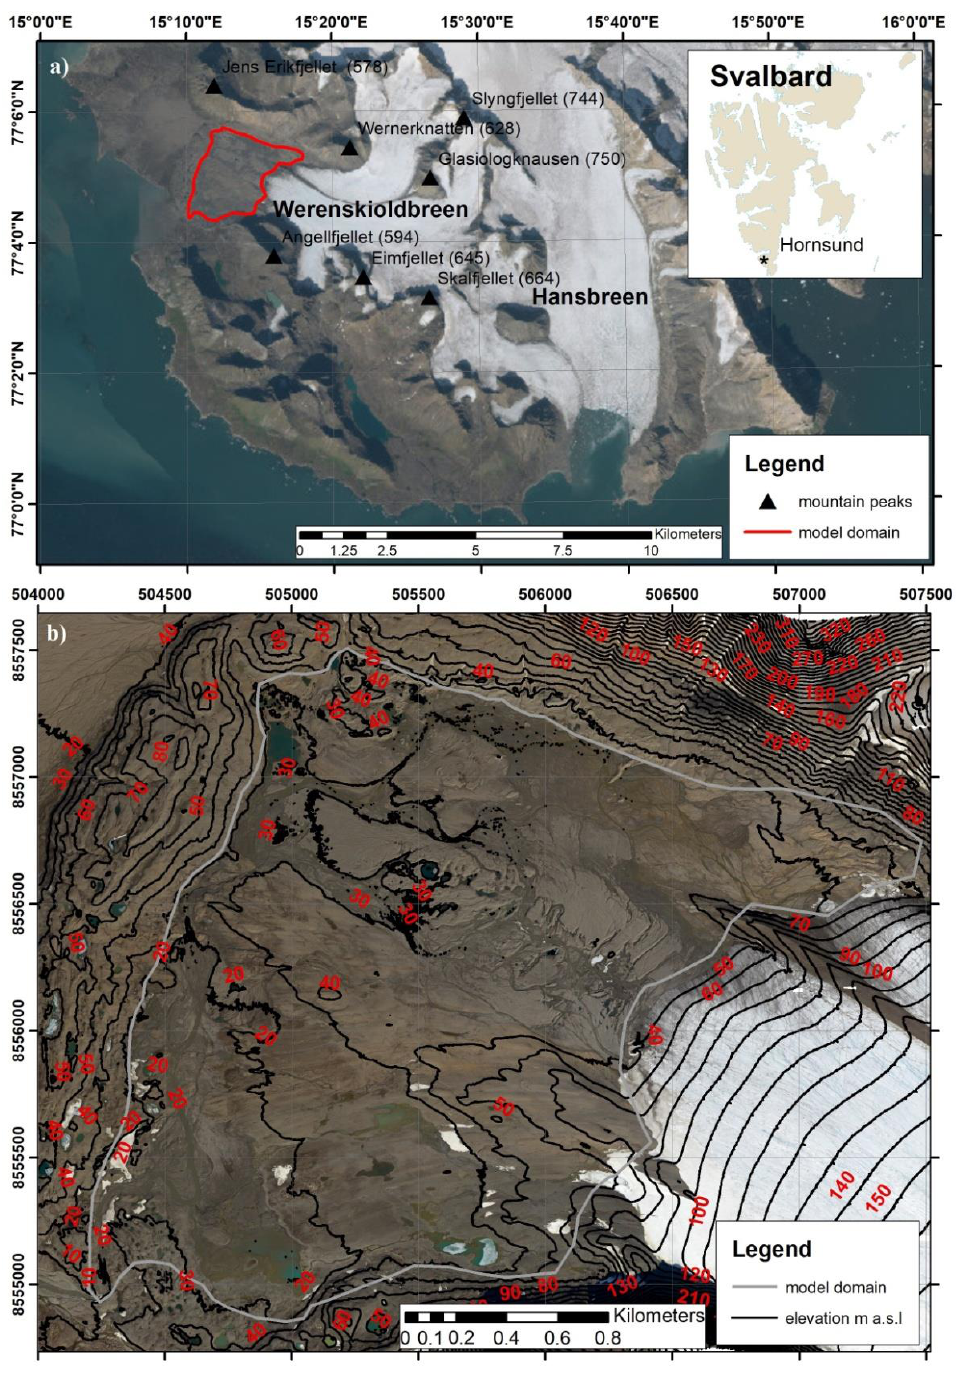
Figure 1. The study area of the Werenskioldbreen basin: ( a ) Hornsund Fjord, south Spitsbergen (base map data: Svalbard Satellite Imagery from the Norwegian Polar Institute Map Data and Services; ( b ) the Werenskioldbreen’s forefield (base data from Polish Polar DataBase: orthomosaic and DEM captured in 2020 based on Dornier images [48]).